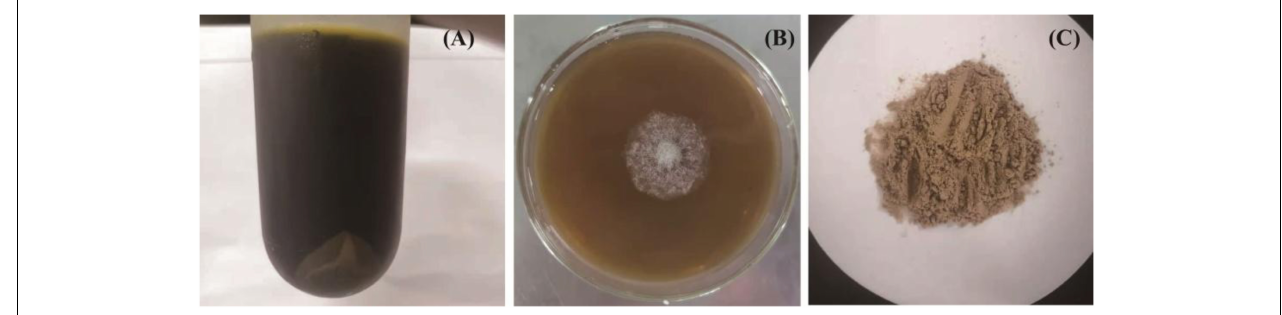
FIGURE 1 | The distilled, heated, and centrifuged sugarcane molasses (A) , growth profile of Chaetomium globosum CGMCC 6882 on sugarcane molasses plate (B) , polysaccharide (CGP-SM) powder obtained from submerged fermentation (C) .